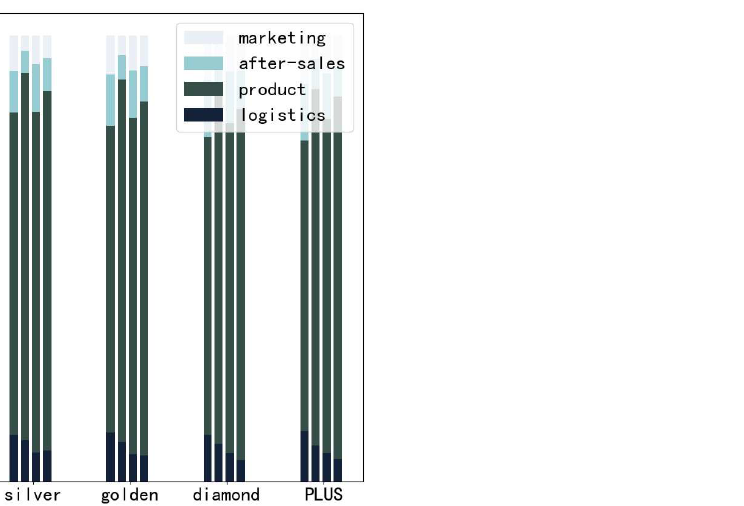
Figure A3. Proportions of main reasons for negative reviews from different user levels. This is a stacked histogram for the proportion of the main reasons for negative reviews. The x -axis corresponds to the five user levels, and the y -axis corresponds to proportions. Additionally, every four bars above every user level represent different categories: from left to right, Gifts and Flowers, Clothing, Computers and Phone and Accessories.